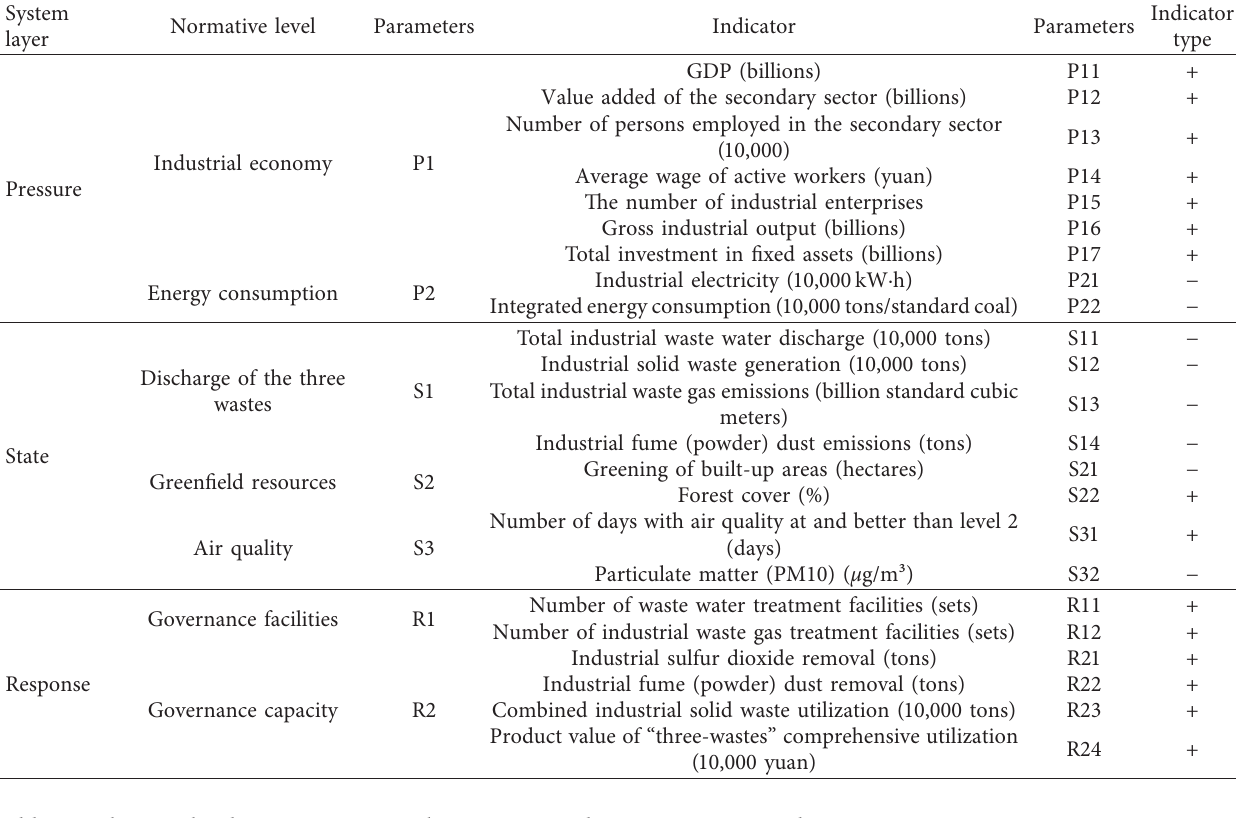
Table 1: PSR model based evaluation index system for urban industrial ecosystems in Liaoning Province.